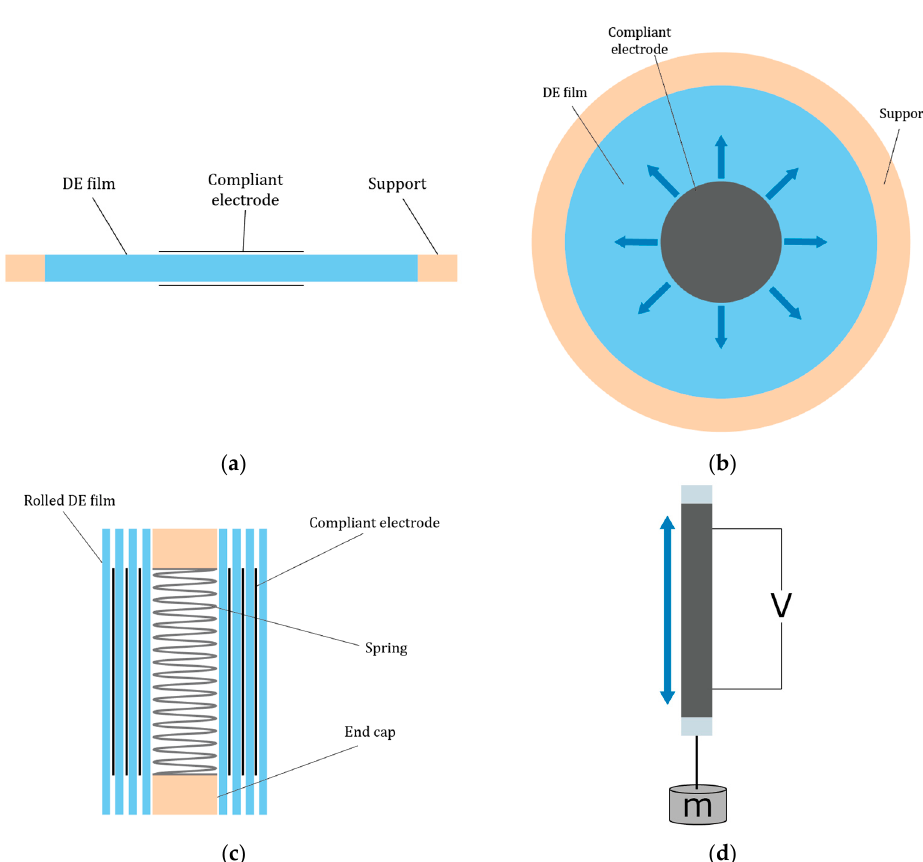
Figure 4. DE actuator configurations: ( a ) Structure of a circular actuator; ( b ) Electrically activated circular actuator; ( c ) Internal structure of a spring roll actuator; ( d ) Electrically activated spring roll actuator with a hanging mass.